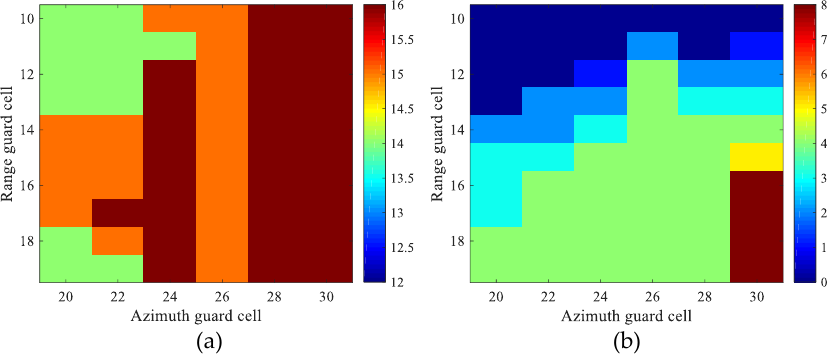
Figure 19. Number of detected targets/ambiguities versus range/azimuth guard cell size: ( a ) number of detected targets; and ( b ) number of detected ambiguities.